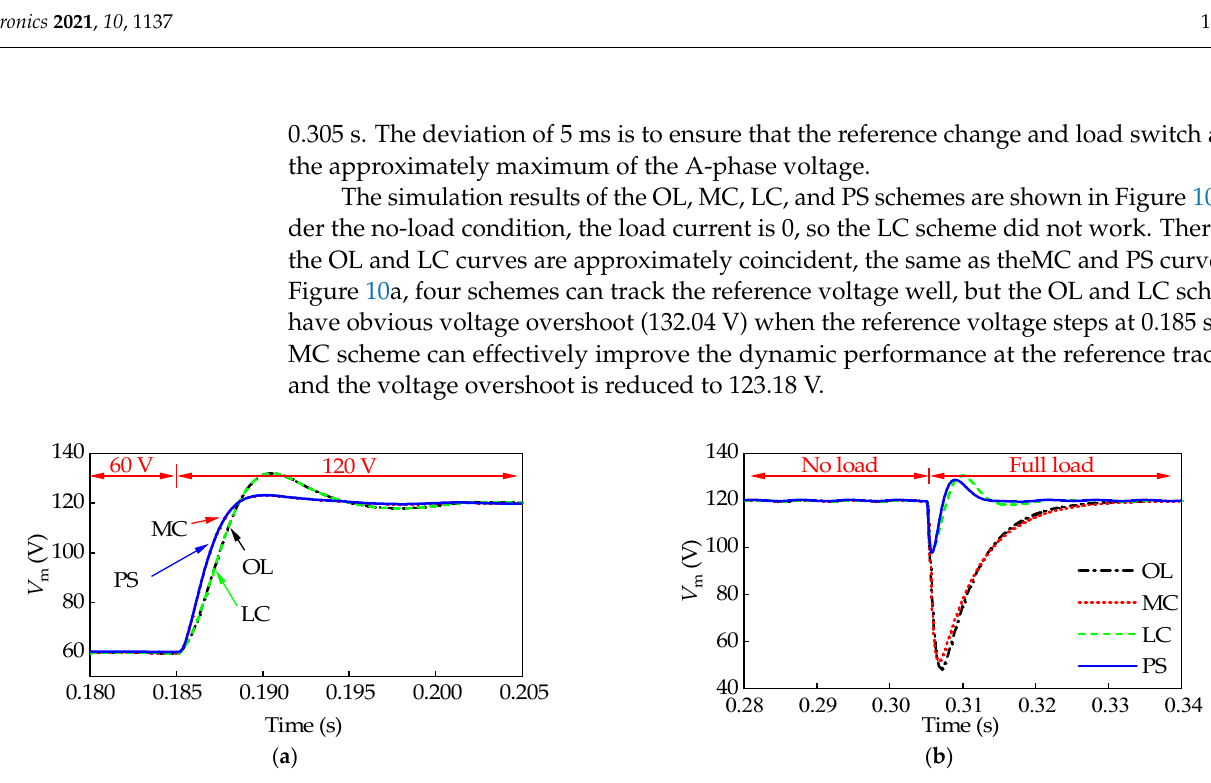
Figure 10. Simulation results: ( a ) Reference steps at 0.185 s; ( b ) Adding load at 0.305 s.